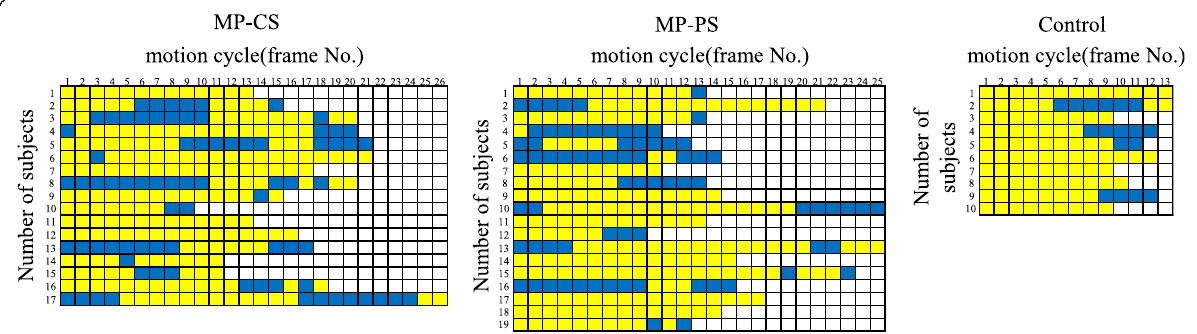
Fig. 5 Changes over time in location of the ICOR in early stance of gait. Blue indicates medial pivot and yellow indicates lateral pivot. The first frame number indicates heel strike and the last frame number indicates contralateral toe-off in each subject. ICOR, instantaneous center of axial